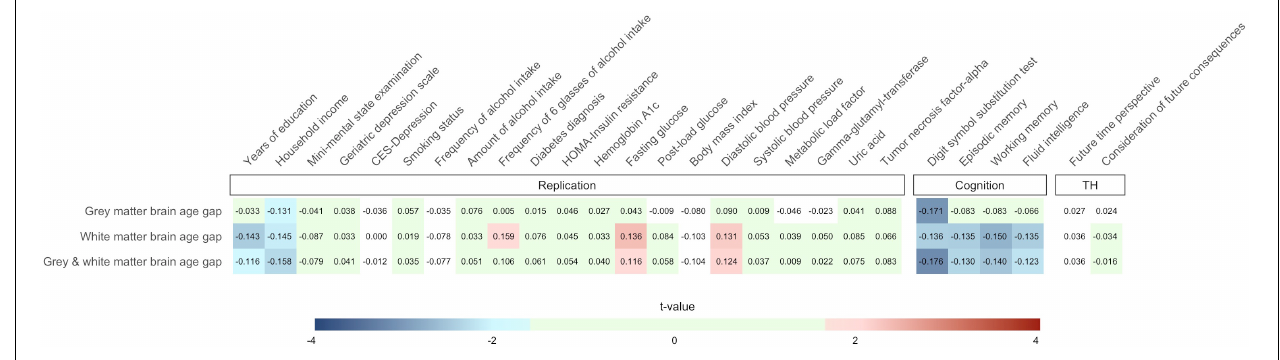
FIGURE 2 | Partial Pearson correlations between the 27 criterion variables and gray matter, white matter, and combined gray and white matter brain age gap. Effects of sex, age, age 2 , and total intracranial volume were partialled out. Only cells containing associations with p < 0.05 (one-tailed) have been assigned with colors of the blue and red color palette. Green cells show associations not reaching nominal significance ( p ≥ 0.05) but with hypothesis-consistent effect directions. Note that the number of observations varied across the criterion measures so that stronger associations do not necessarily reflect results with lower p -values. We provide an interactive version of this plot at https://github.com/pjawinski/base2/. TH, time horizon.